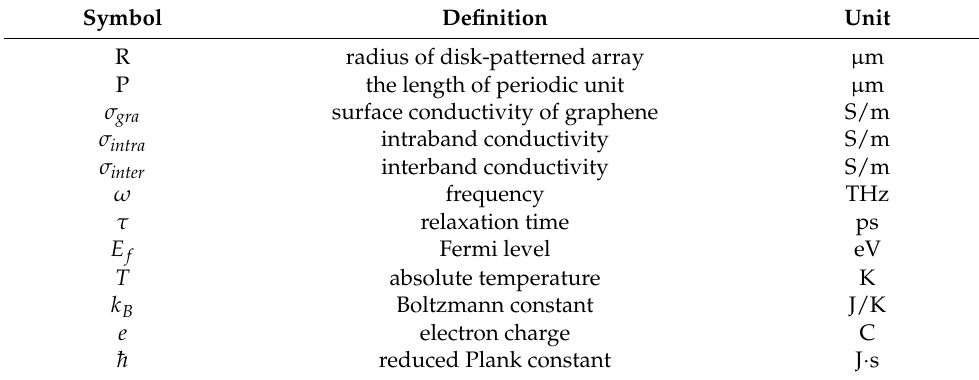
Table 1. Nomenclature table of abbreviations and parameters for the proposed absorber.